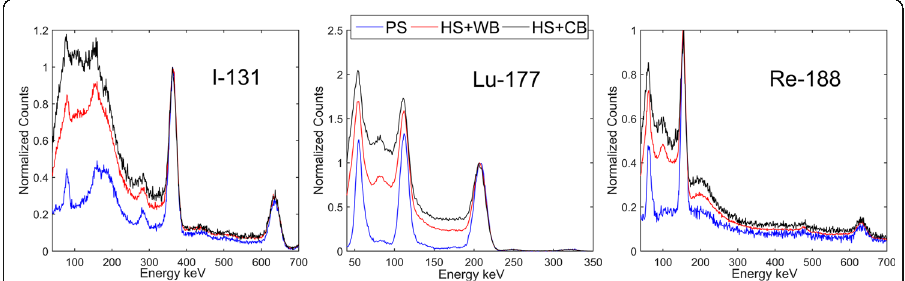
Fig. 2 Simulated energy spectra as would be acquired by the SPECT camera from emissions of 131 I, 177 Lu, and 188 Re. For each isotope, a point source scanned in air (blue line) and a 100-mL hot sphere placed at the center of a 20-cm diameter cylindrical phantom filled with non-radioactive water (black line) and warm (red line) water were